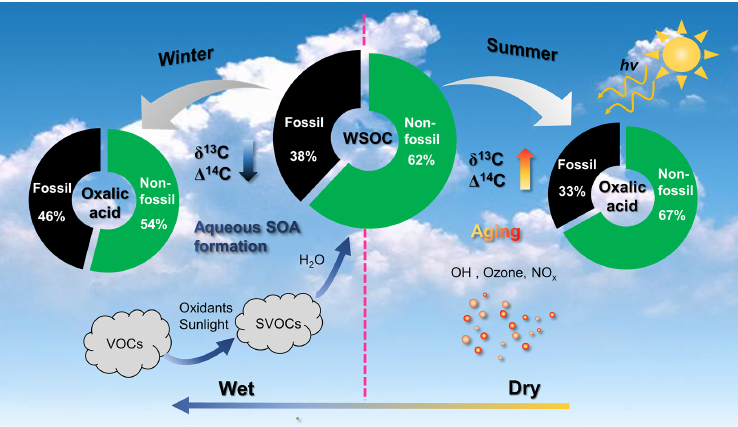
Figure 7. Schematic of the atmospheric fates of secondary organic aerosols (SOAs) in winter and summer. VOCs: volatile organic com- pounds; SVOCs: semi-volatile organic compounds; WSOC: water-soluble organic